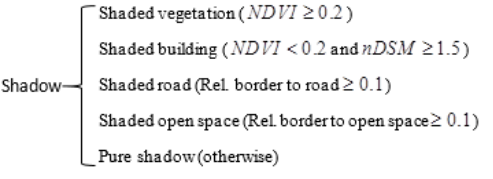
Figure5. The rule set of shadow areas